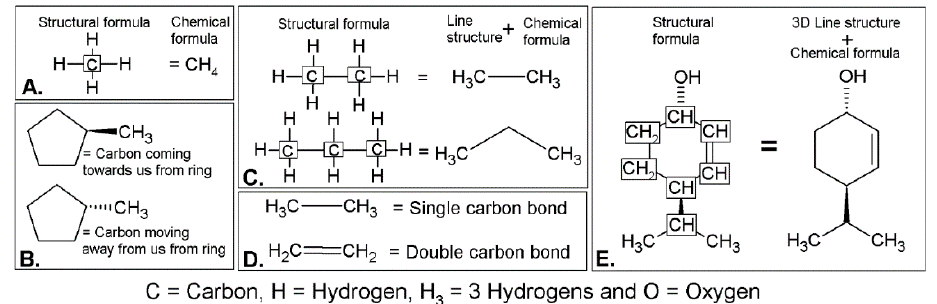
Figure A2. Lessons A–E demonstrating how to interpret a line structure representation of an organic molecule. ( A) The difference between a structural formula and a chemical formula; ( B) How spatial distribution (stereochemistry) is conveyed; ( C) The difference between structural formula and line structures that use chemical formula for methyl groups; ( D) Single and double bonds; ( E) The structural formula compared to its equivalent line structural diagram utilizing a 3D effect and chemical formula for methyl